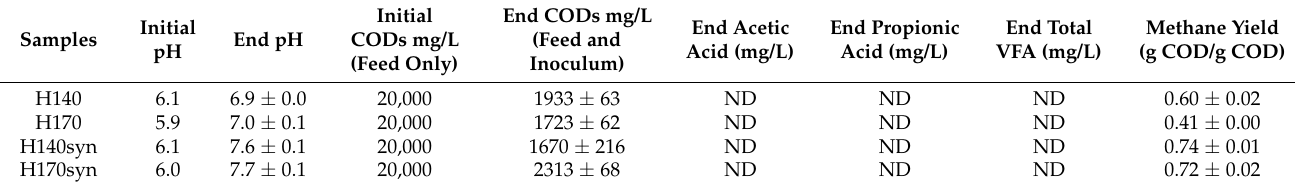
Table 4. Initial pH values, end AMPTS II liquid characteristics, and methane yield. VFA, volatile fatty acids.